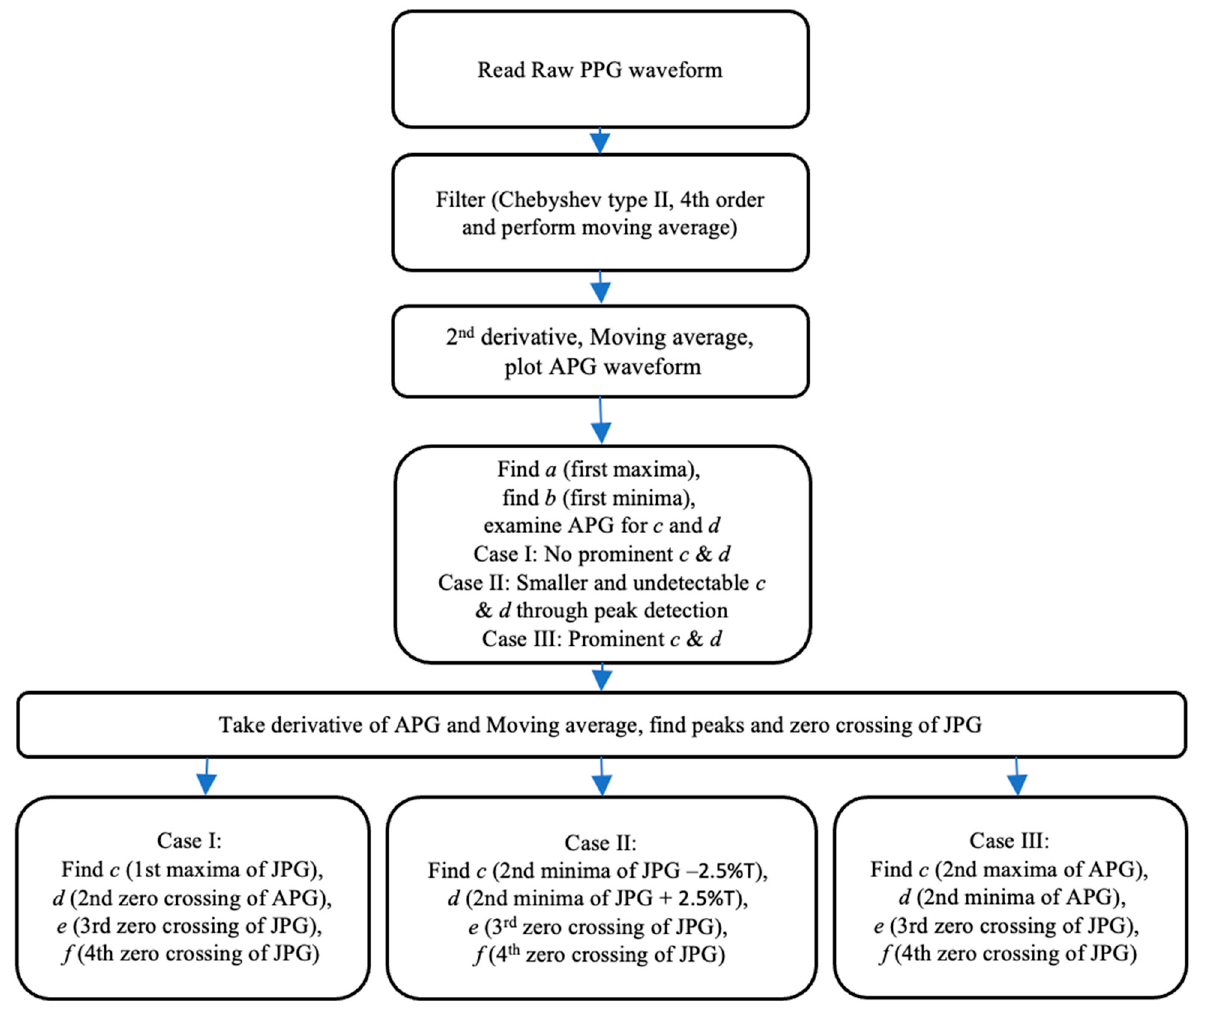
Figure 4. Flowchart of the CnD algorithm for filtering, examining, and identifying fiducial points.